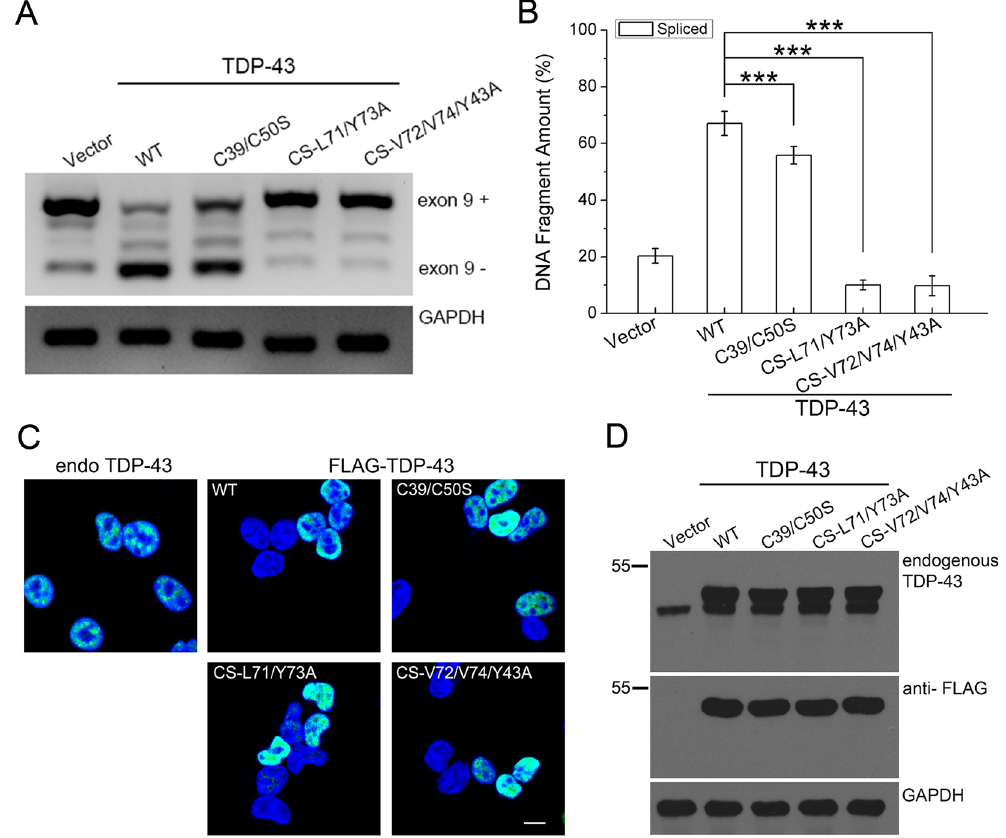
Figure 6. Effects of dimer-interface mutations on the RNA splicing activity of TDP-43. ( A ) Effects of TDP-43, its Cys mutant (C39/C50S) and dimer-interface mutants (CS-L71/Y73A and CS-V72/V74/Y43A) on CFTR exon 9 splicing. The GT13T5 reporter was co-transfected with the FLAG-tagged plasmids into HEK 293 T cells, respectively. Exon 9 + stands for unspliced cDNA fragment, while exon 9 − denotes spliced cDNA. ( B ) Quantification of the spliced RT-PCR products of TDP-43 and its mutants based on band intensity. Data were analyzed by one-way ANOVA and represented as Mean ± SD (n = 3). *** p < 0.001. ( C ) Immunofluorescence microscopic images showing nuclear localization of FLAG-TDP-43 and its mutants in HEK 293 T cells. TDP-43 and its mutants were stained with mouse anti-TDP-43 or anti-FLAG (green), and the nuclei were stained with Hoechst (blue). The images are shown with a magnification of 3 times (3 X). Scale bar = 10 µ m. ( D ) Western blot showing the expression levels of the protein species for CFTR splicing